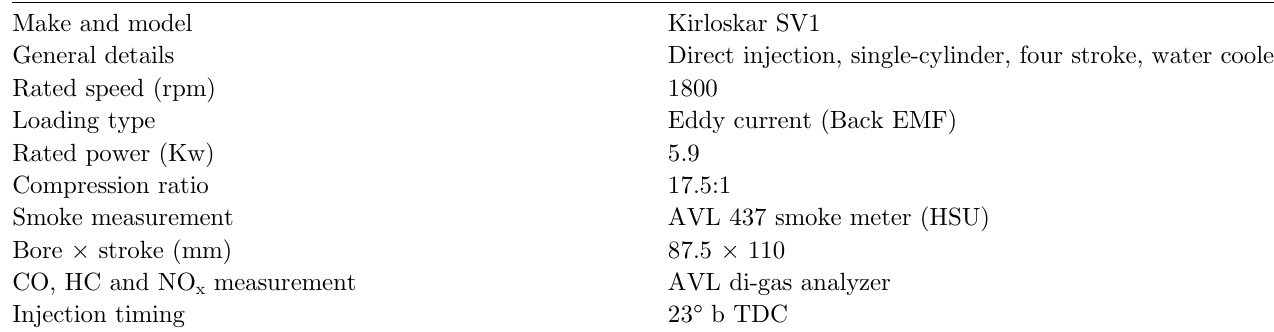
Table 3. Test engine speci fi